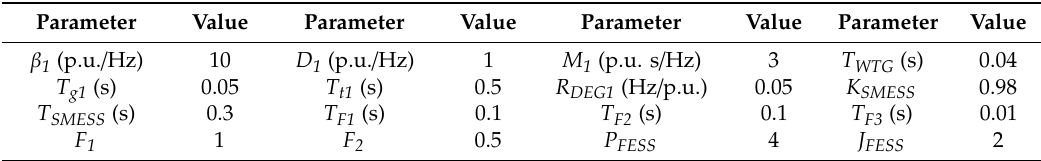
Table 2. Parameters of microgrid 2.